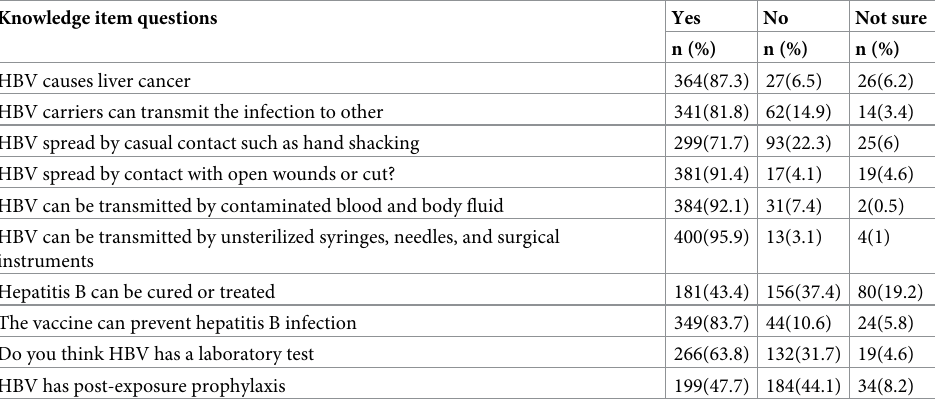
Table 2. Knowledge level of the study participants at Wolkite University, 2020 (n =